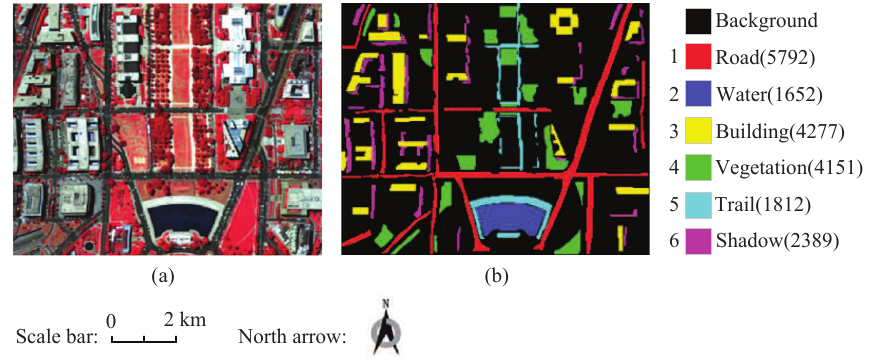
Figure 4. Washington DC Mall hyperspectral image. ( a ) HSI in false-color; ( b ) Ground-truth